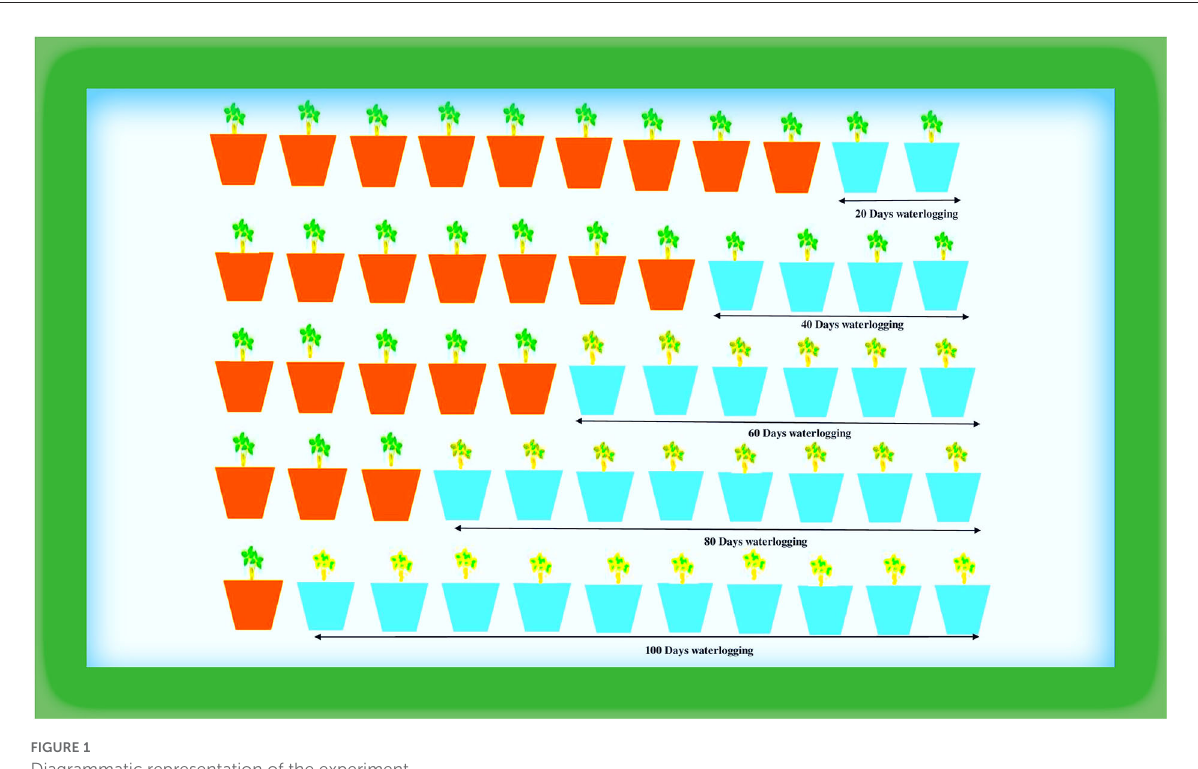
FIGURE1 Diagrammatic representation of the